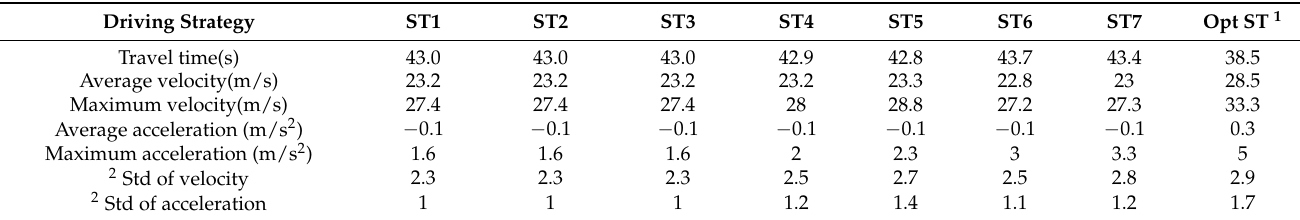
Table 2. Travel time through the DIA of different strategies for SV .